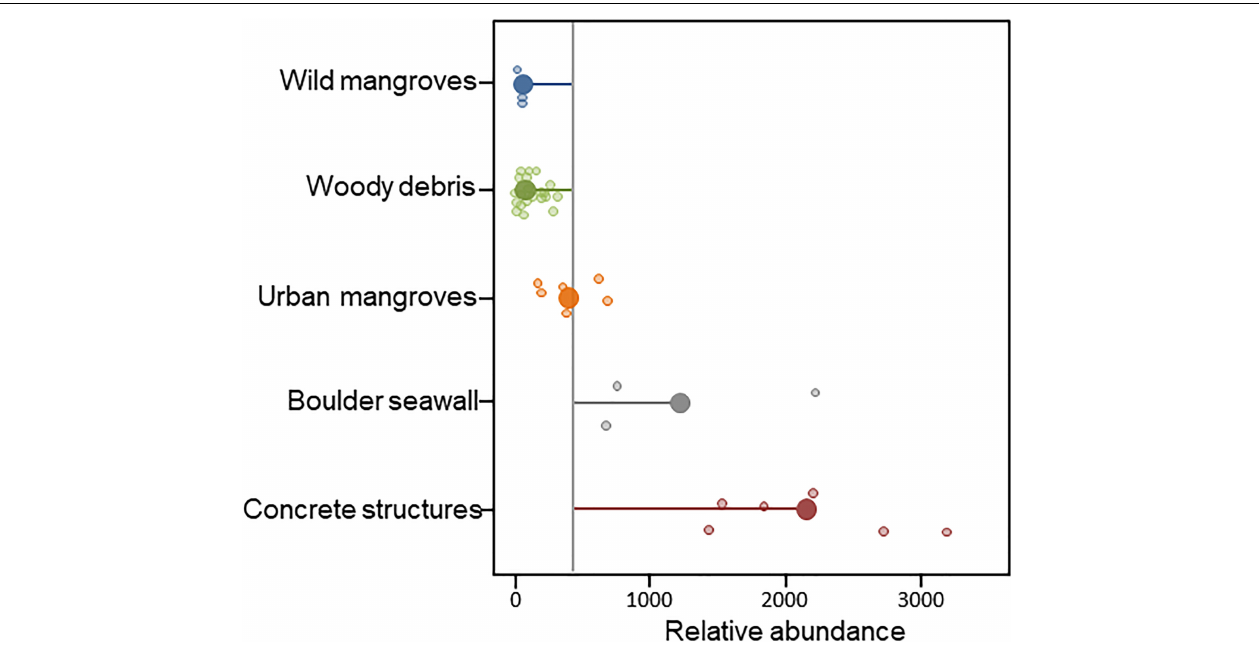
FIGURE 2 | Jitter-pop plot of the relative abundance (number of snails per 20 m sampling) of Littoraria angulifera in different habitats at the Urabá Gulf estimated from data taken in 2009, 2019, and 2020. The plot was generated in R using the “ggplot2” library. Gray line: overall mean; lollypops: mean for each habitat and distance to the general